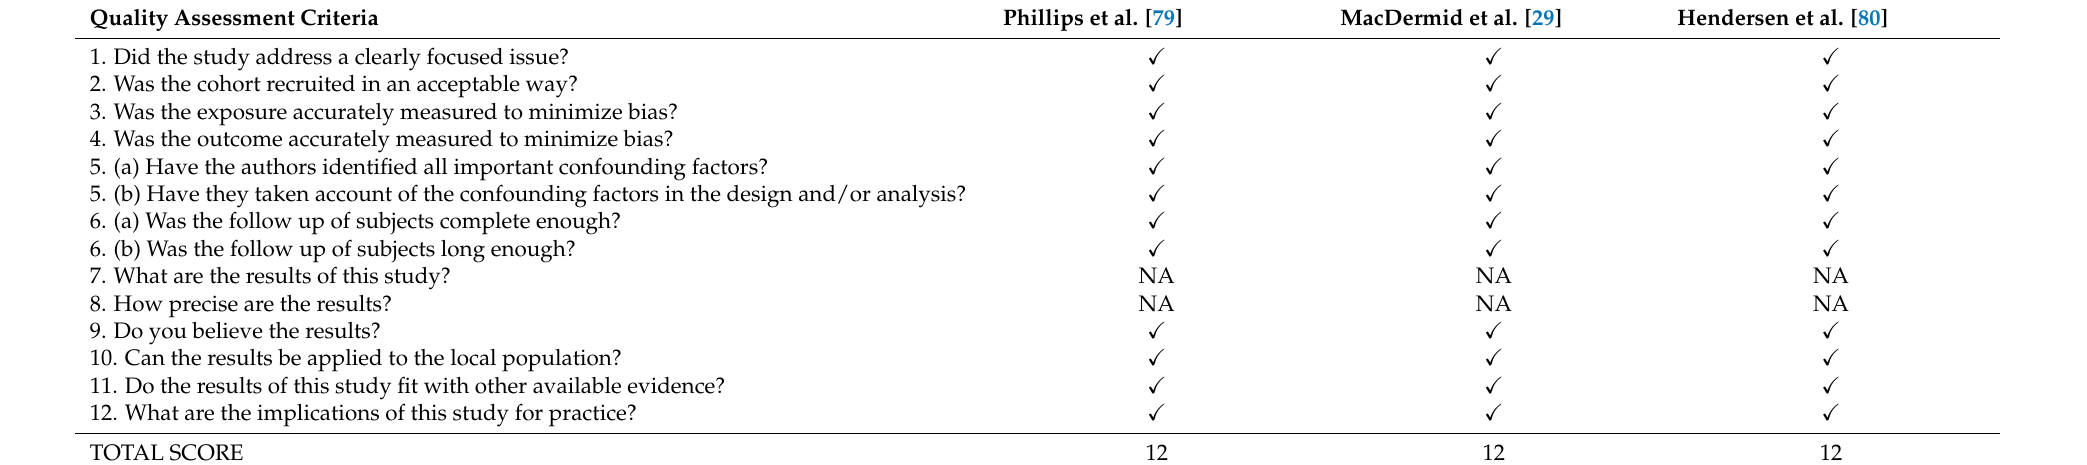
Table 2. Critical appraisal of cohort studies using the Critical Appraisal Skills Programme